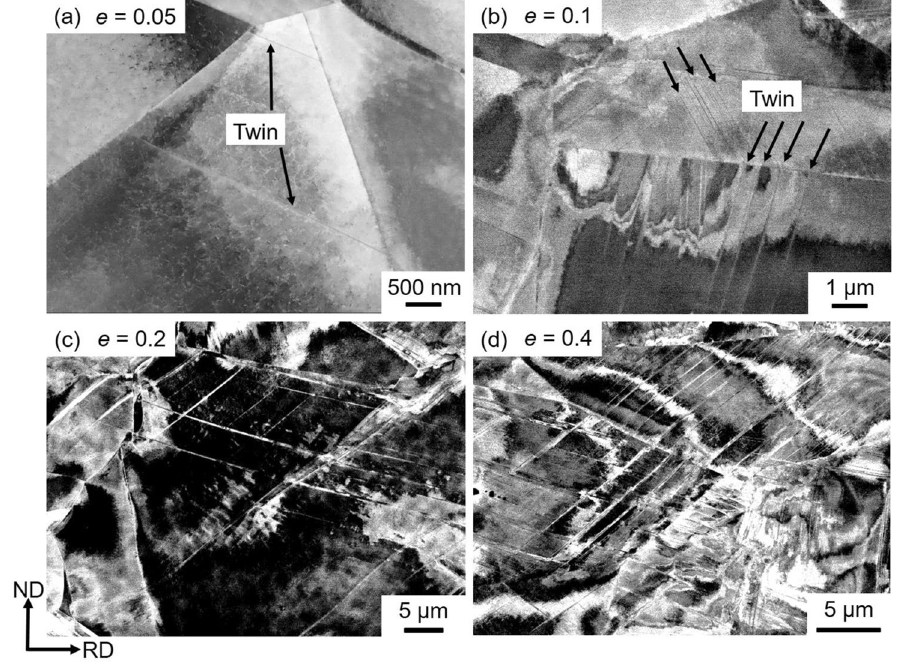
Figure 5. ECC images of the specimens with the mean grain sizes of 15.4 μm tensile-deformed to engineering strains of ( a ) e = 0.05, ( b ) 0.1, ( c ) 0.2 and ( d ) 0.4.